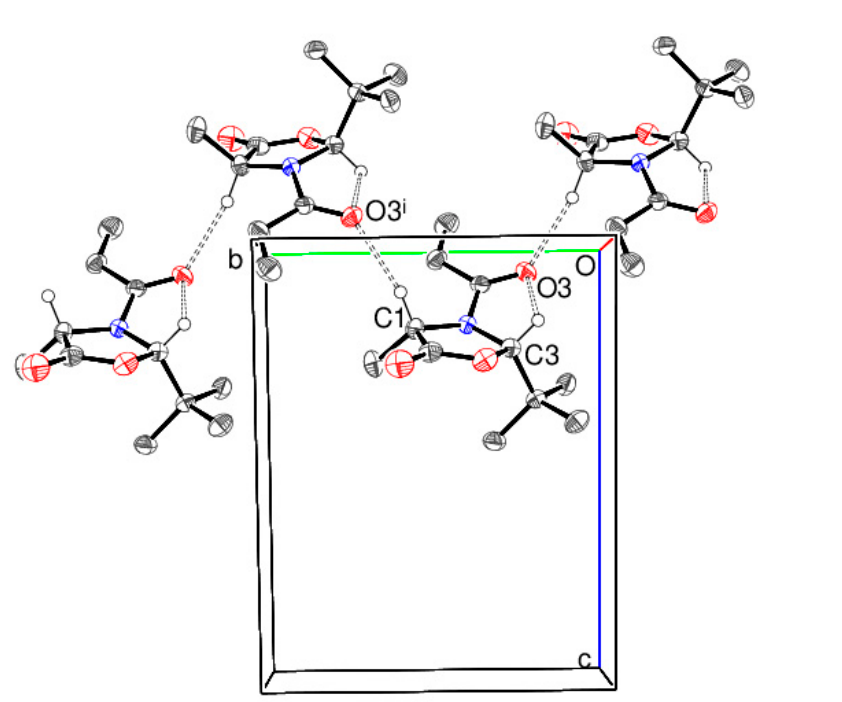
Figure 5. Fragment of the crystal structure of ( I ) showing part of an [010] chain linked by C1–H1 ··· O3 hydrogen bonds. Symmetry code: (i) 1 − x , ½ + y , − z .